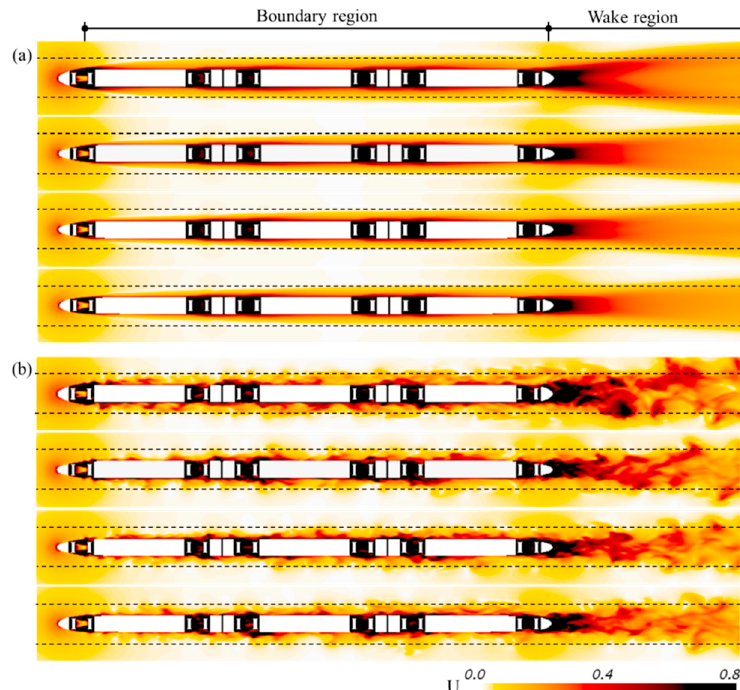
Figure 16. Slipstream velocity at height of 0.2 m from TOR. ( a ) Time-averaged U , and ( b ) instantaneous U (from top to bottom: 4, 7, 9, and 12 m. Black dashed line is 3 m from COT.).